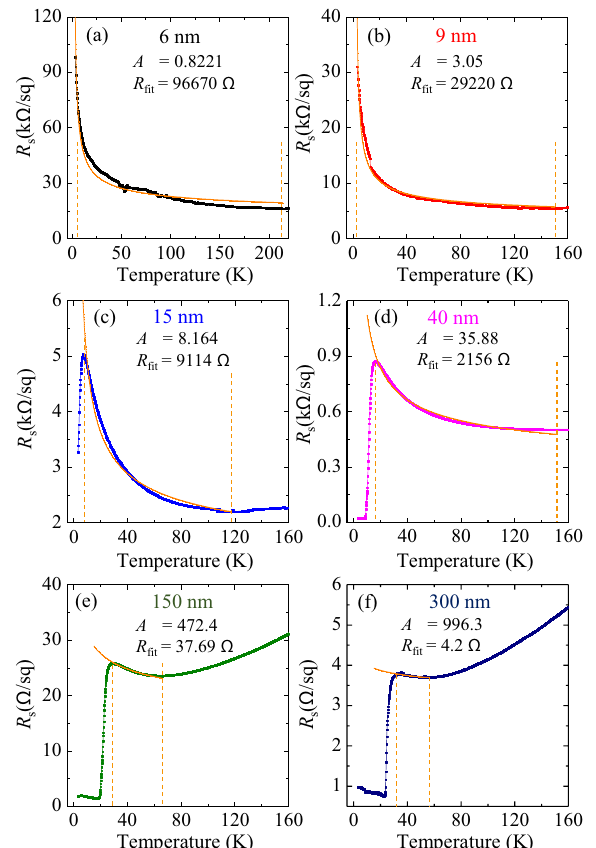
Figure 2. Theoretical fitting to the resistance peak for ( a ) 6 nm ( b ) 9 nm ( c ) 15 nm ( d ) 40 nm ( e ) ~150 nm and ( f ) ~300 nm thick films. The parameters A and R fit were determined for each film thickness by fitting the theoretical curve (orange solid line) associated with the weak localization and interaction in a diffusion channel to the experimental data (square symbols) in the temperature range indicated by the two vertical dashed